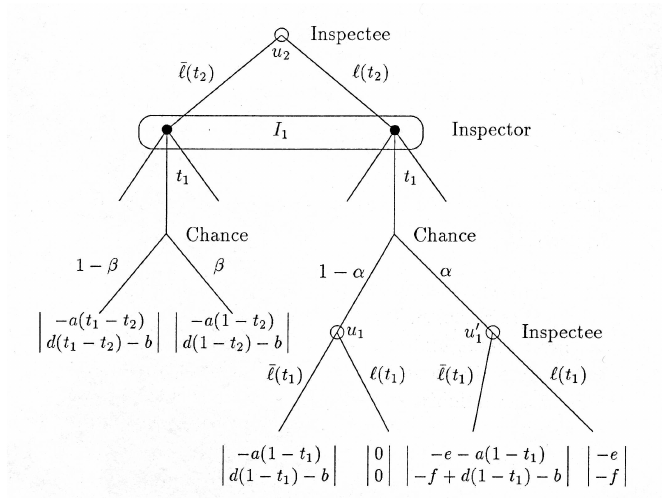
Figure 3. Extensive form of the two person game between the inspector and the inspectee for one interim